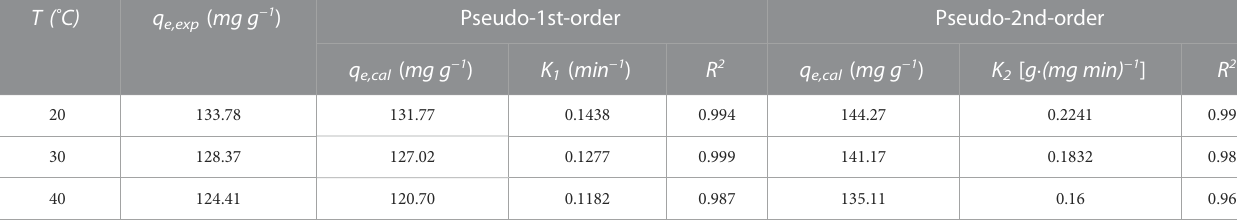
TABLE 3 Relevant parameters of pseudo fi rst-order and pseudo second-order models at different temperatures. T ( ° C)